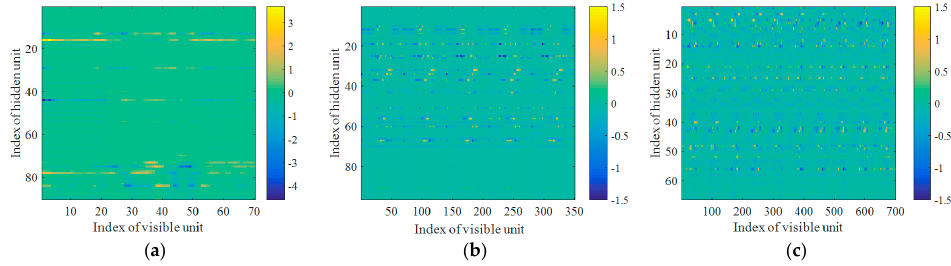
Figure 6. weight matrices W or filters learnt by Dis-iRBMs, ( a ) L = 1; ( b ) L = 5; ( c ) L = 10.